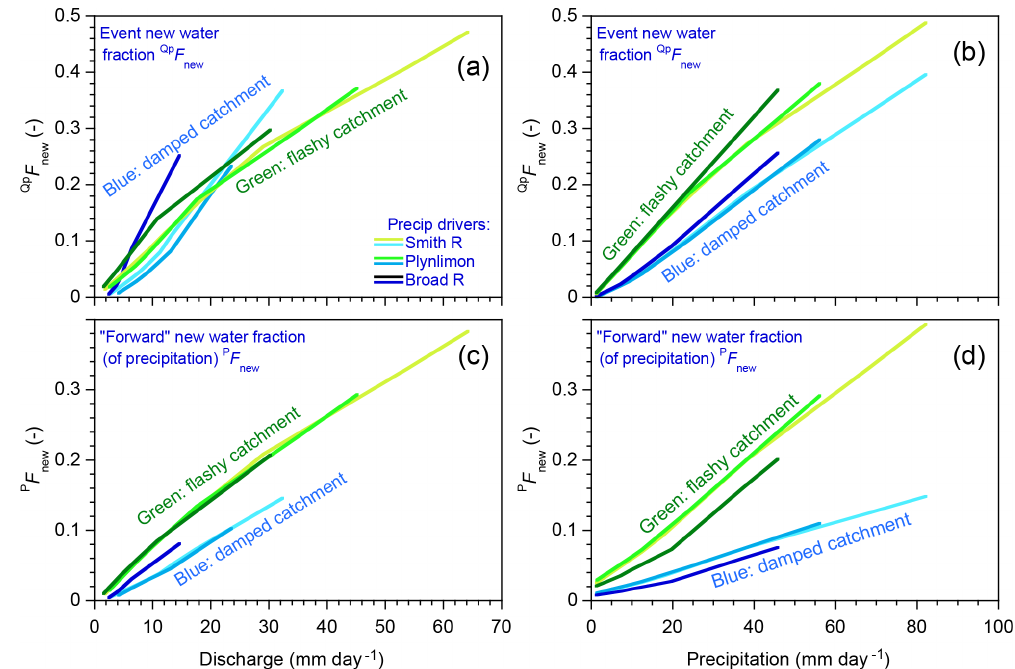
Figure 8. Effects of precipitation climatology and catchment properties on discharge dependence and precipitation dependence of new water fractions. The lines plotted here superimpose the model age-tracking results (solid lines) from Figs. 6 and 7. Panels (a) and (d) show how event new water fractions ( Qp F new , Sect. 2.3) and forward new water fractions ( P F new , Sect. 2.6) vary as functions of discharge and precipitation, respectively. Green and blue lines show benchmark model behavior under the flashy and damped parameter sets, with three levels of brightness corresponding to the three different precipitation climatologies: Mediterranean climate (Smith River, lightest colors), humid maritime climate (Plynlimon, intermediate colors), and humid temperate climate (Broad River, darkest colors). When event new water fractions are plotted as functions of discharge (a) , different catchments and precipitation climatologies overlap. By contrast, in the other three panels (and particularly in d , which shows forward new water fractions as functions of precipitation), the lines for the flashy catchment and the damped catchment are clearly distinct from one another, regardless of precipitation climatology. This suggests that these patterns may be diagnostic of the internal workings of the catchment, but relatively insensitive to the particular rainfall